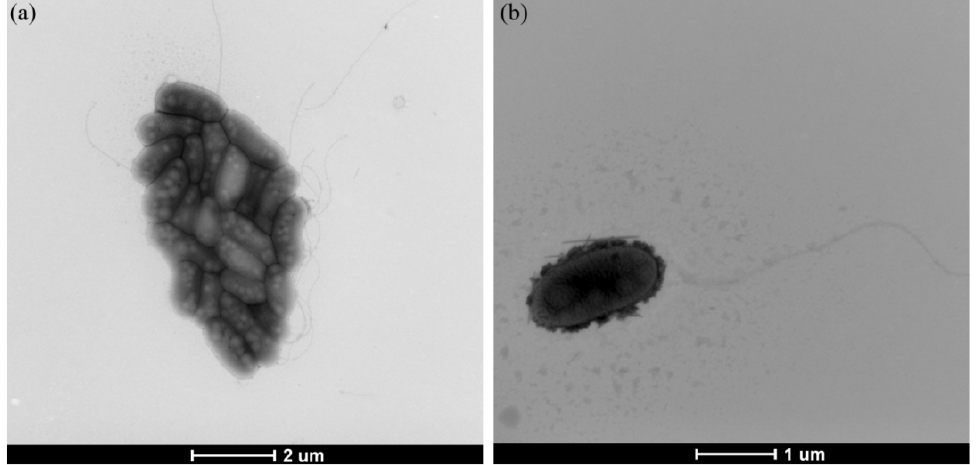
Figure 1. Morphological characteristics of BsNLG8 under the transmission electron microscope. ( a ) The picture shows a monotricha with multiple cells clustered together. ( b ) The rod-like morphology of BsNLG8 cells is shown. Table 1. Physiological and biochemical characteristics of BsNLG8. No.